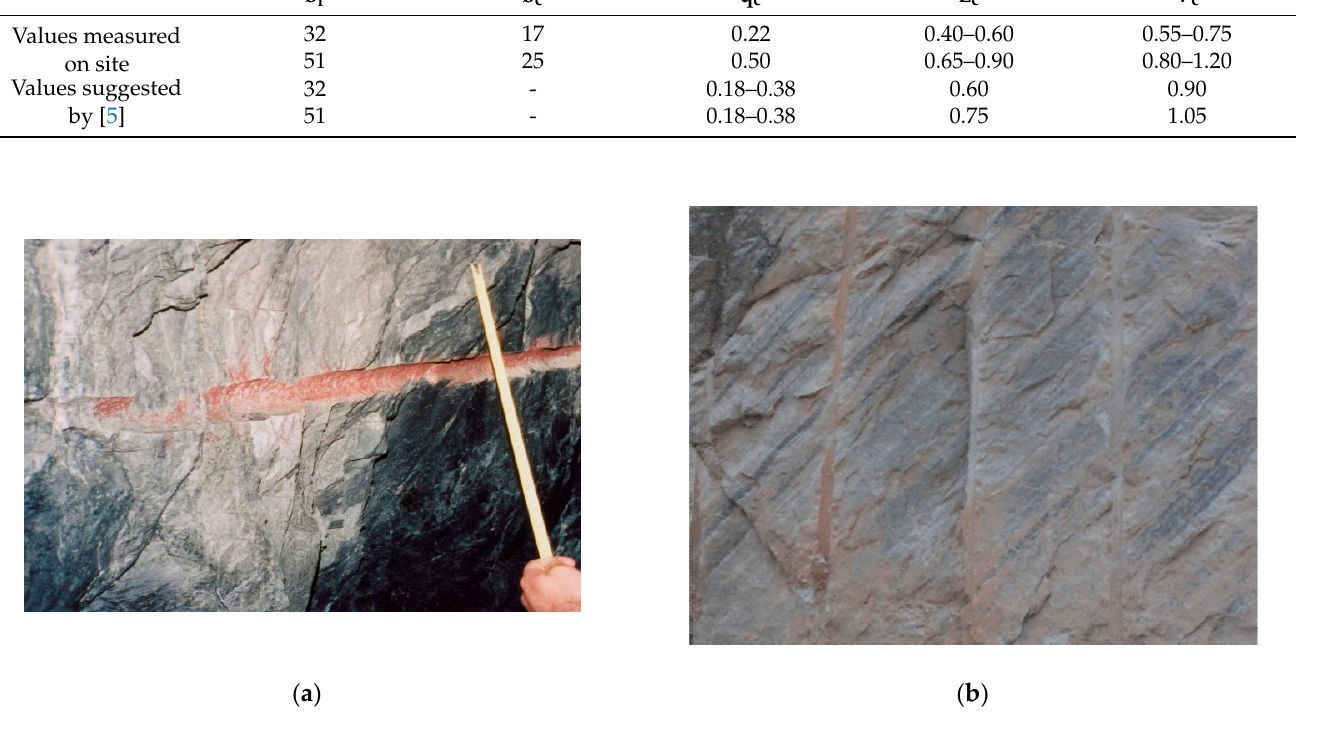
Figure 3. Examples of smooth blasting: ( a ) half cast clearly observable after a blast in tunnel driving; ( b ) result of a contour blast in open-pit mining [4].